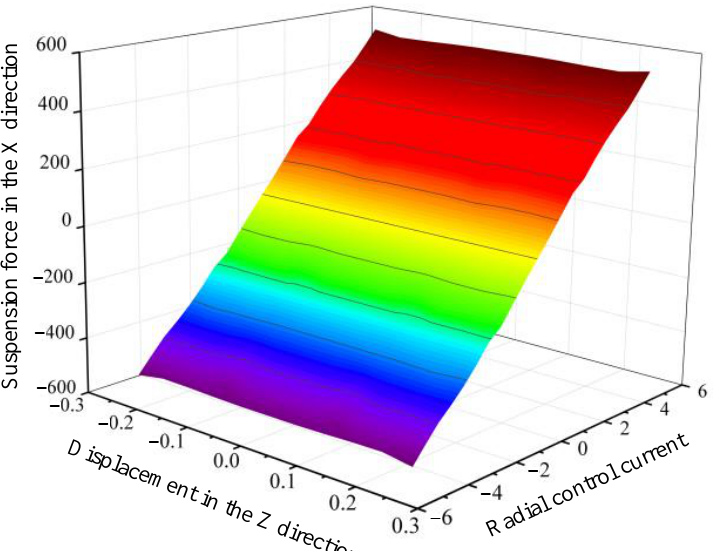
Figure 10. The influence of axial displacement on the radial suspension force–current characteristics in X direction.